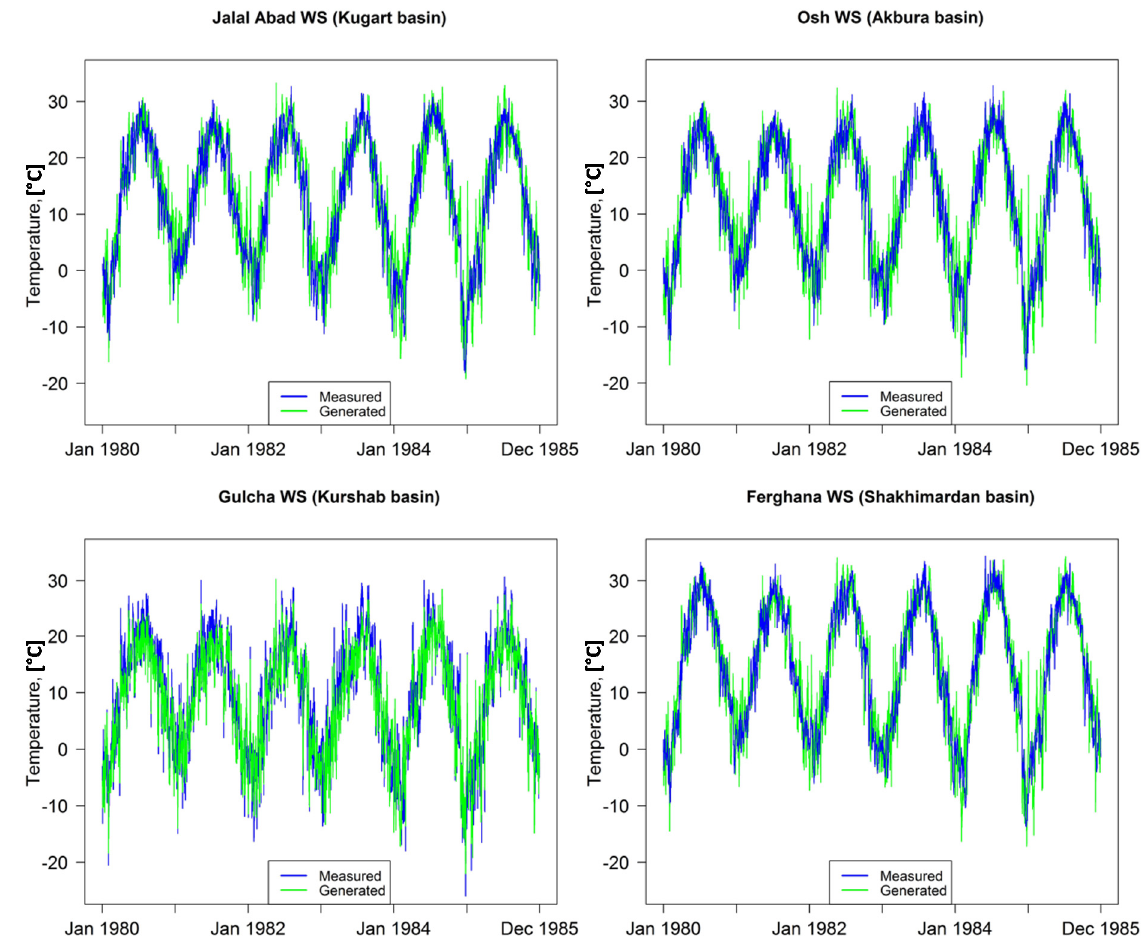
Figure 6. Time series plots of generated and measured temperature at the corresponding weather stations (WS) of the four studied river